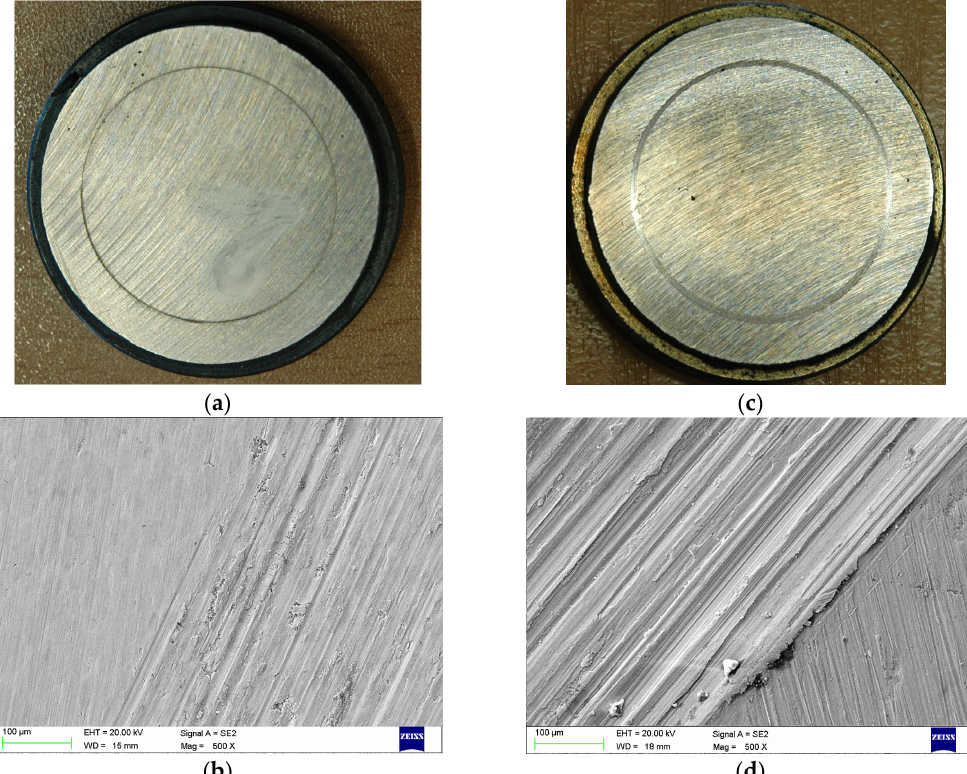
Figure 13. A view of the discs after the tribological ball ‐ on ‐ disc wear tests and SEM micrographs of wear tracks; ( a , b ) the disc with a coating LC2 type, and ( c , d ) the disc with a coating LC4 type (Table 2).